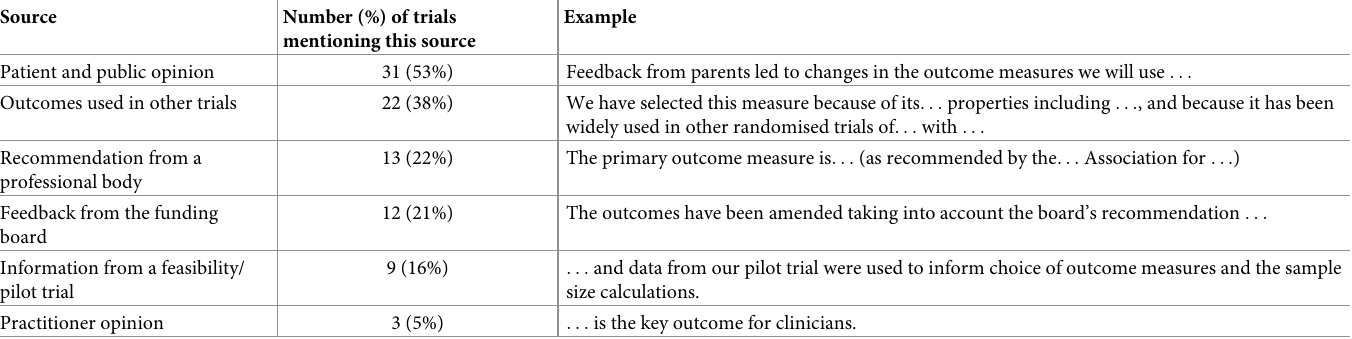
Table 1. Examples of the sources applicants used to inform their choice of outcomes as extracted from the applications. Source Number (%) of trials mentioning this source